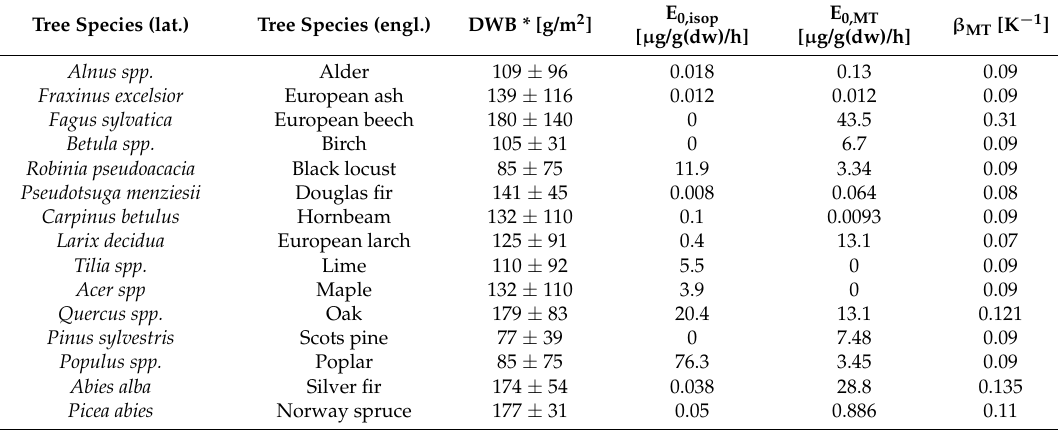
E 0,isop E 0,MT β MT [K − 1 ] [ µ g/g(dw)/h] [ µ g/g(dw)/h]